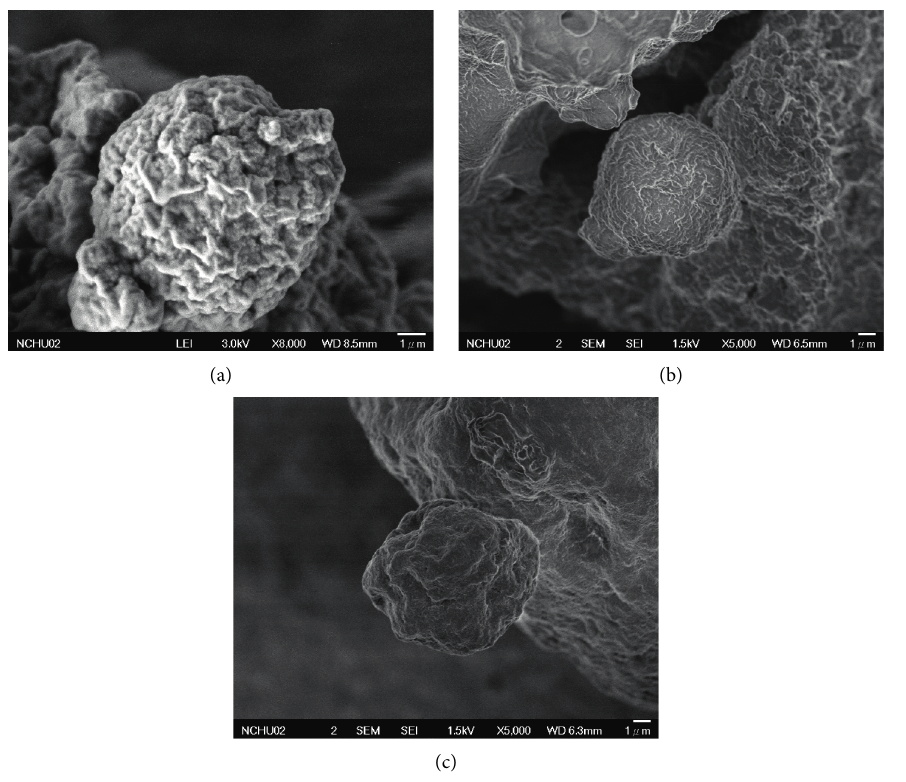
Figure 2: SEM images of (a) control, (b) Sample 1, and (c) Sample 4. Table 3: Encapsulation efficiencies (EEs), drug loading content (DLC), and yields of production (YPs) of prepared microcapsules. Sample